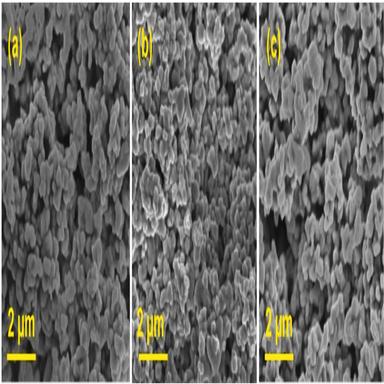
SEM images of LZTNO (a) x ¼ 0, (b) x ¼ 0.05, (c) x ¼ 0.1.